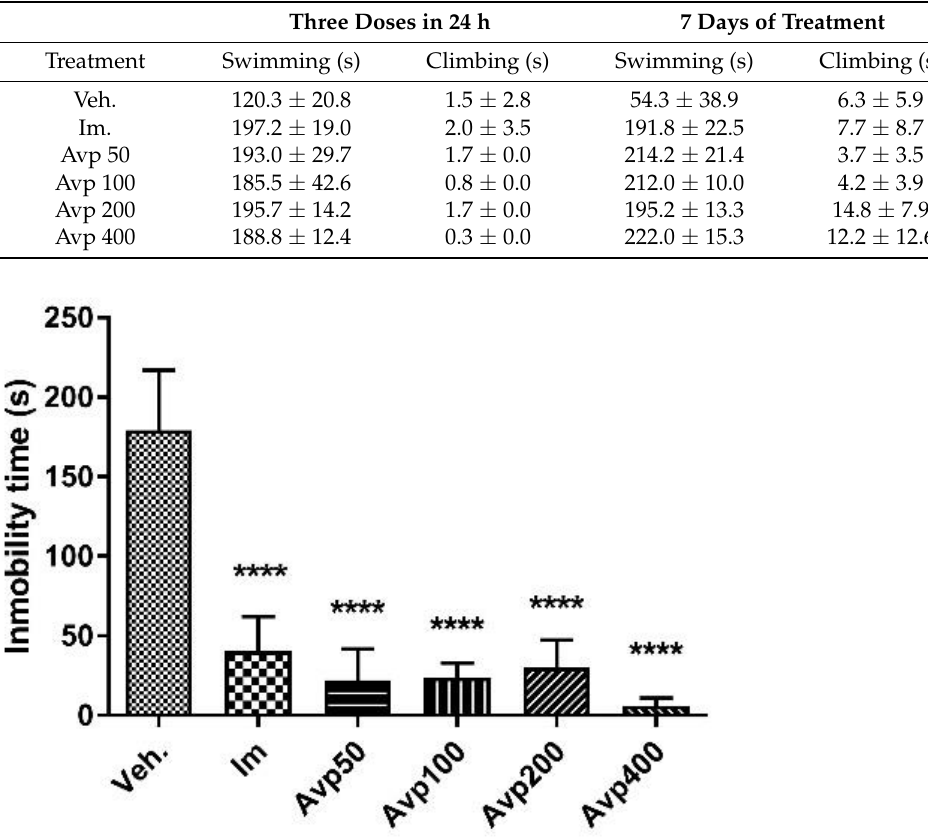
Figure 8. Immobility time (s) in the forced swimming test for the groups ( n = 6) treated orally for 7 days with Aloysia virgata var. platyphylla (Avp). Im.: imipramine. Veh: tween 80, 10%. The data correspond to the mean ± SD. One-way ANOVA and Dunnett’s post hoc test were performed. **** p < 0.0001. Table 2. Climbing and swimming behavior time of mice ( n = 6) after treatment with three doses in a 24-h period of Aloysia virgata var. platyphylla.